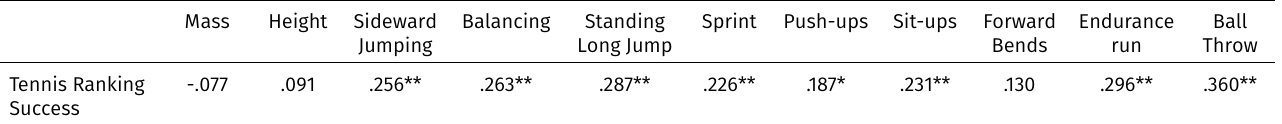
Table 3. ‒ Bivariate correlations of the different U9 test results and the chance to achieve a ranking position in the official youth national ranking lists of the German Tennis Federation (* p ≤ 0.05; ** p ≤